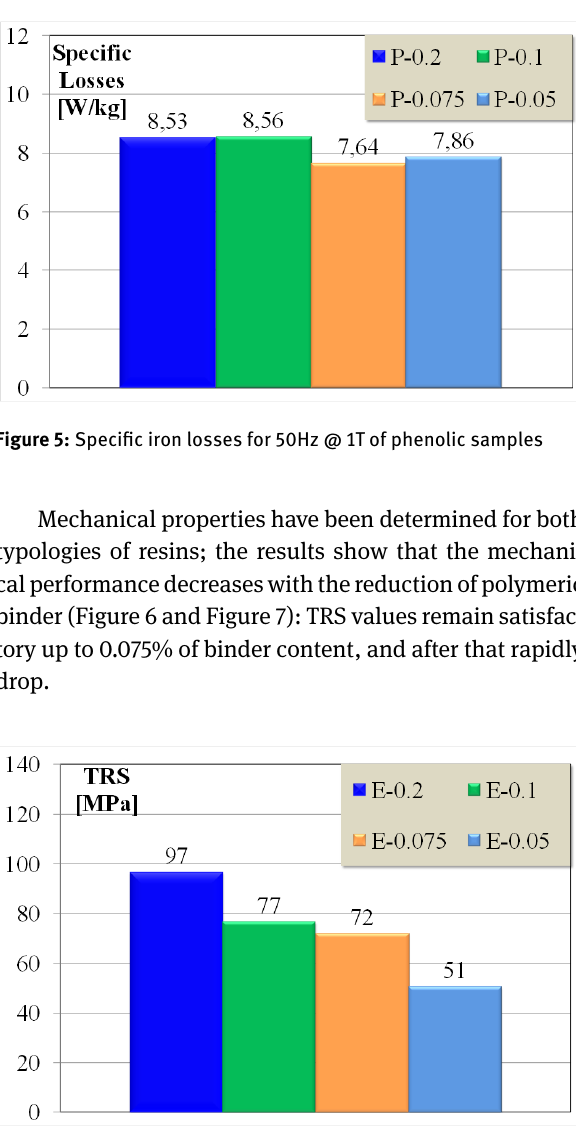
Figure 3: Magnetic characteristics of Phenolic SMC pressed at 800 MPa